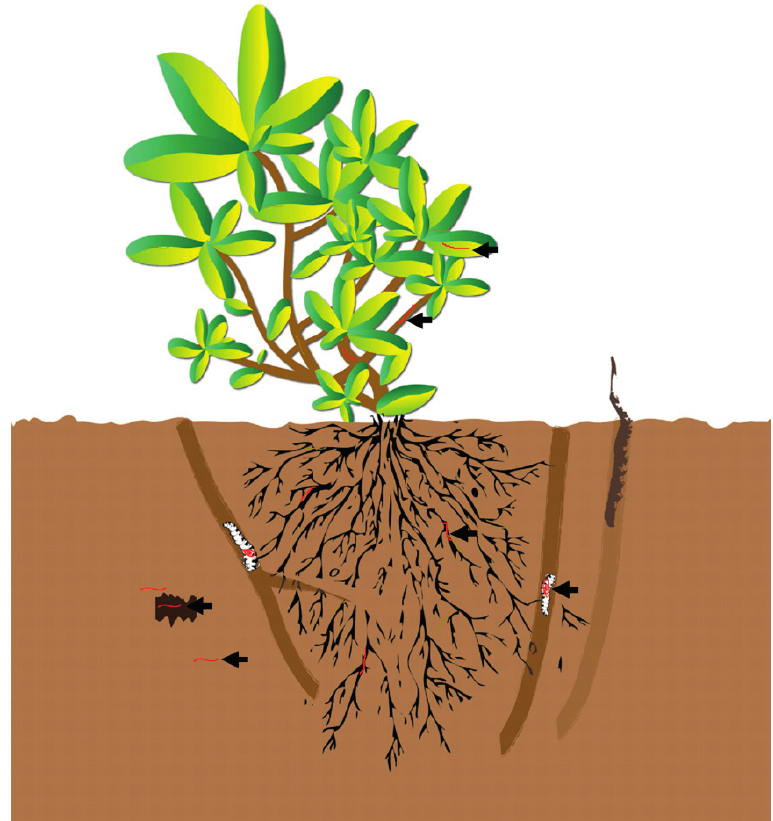
Figure 4. Relationships of O. sinensis with plants and caterpillars. O. sinensis are indicated with the red line and denoted by the